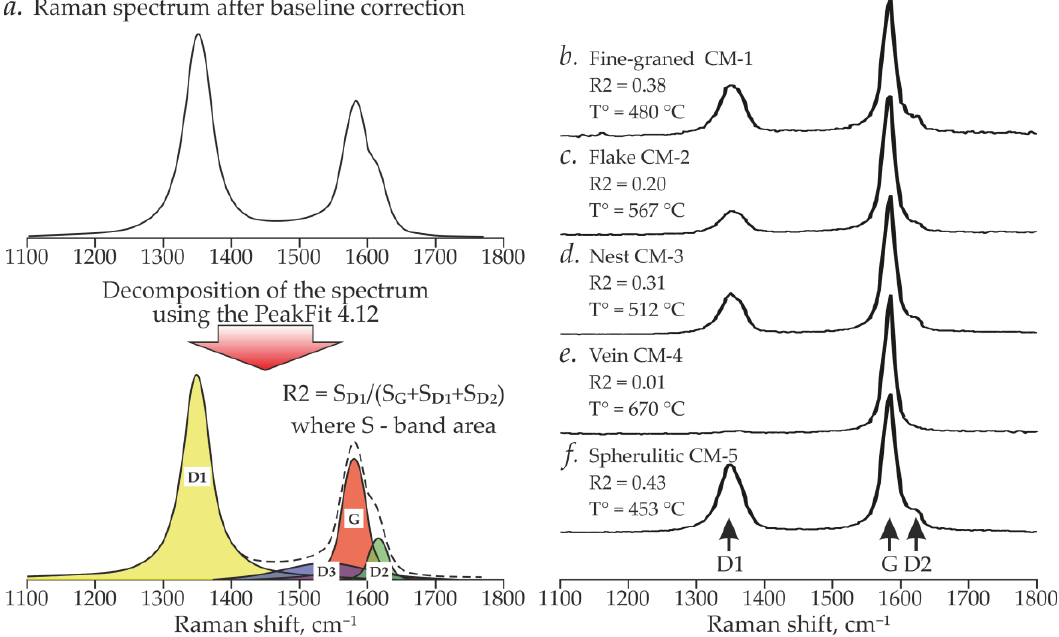
Figure 3. ( a ) Schematic decomposition diagram of CM Raman spectrum in the first-order region (1100–1800 cm –1 ) and ( b – f ) characteristic spectra (in the same region) of different CM morphologies from the studied rocks of the Keivy Terrane.